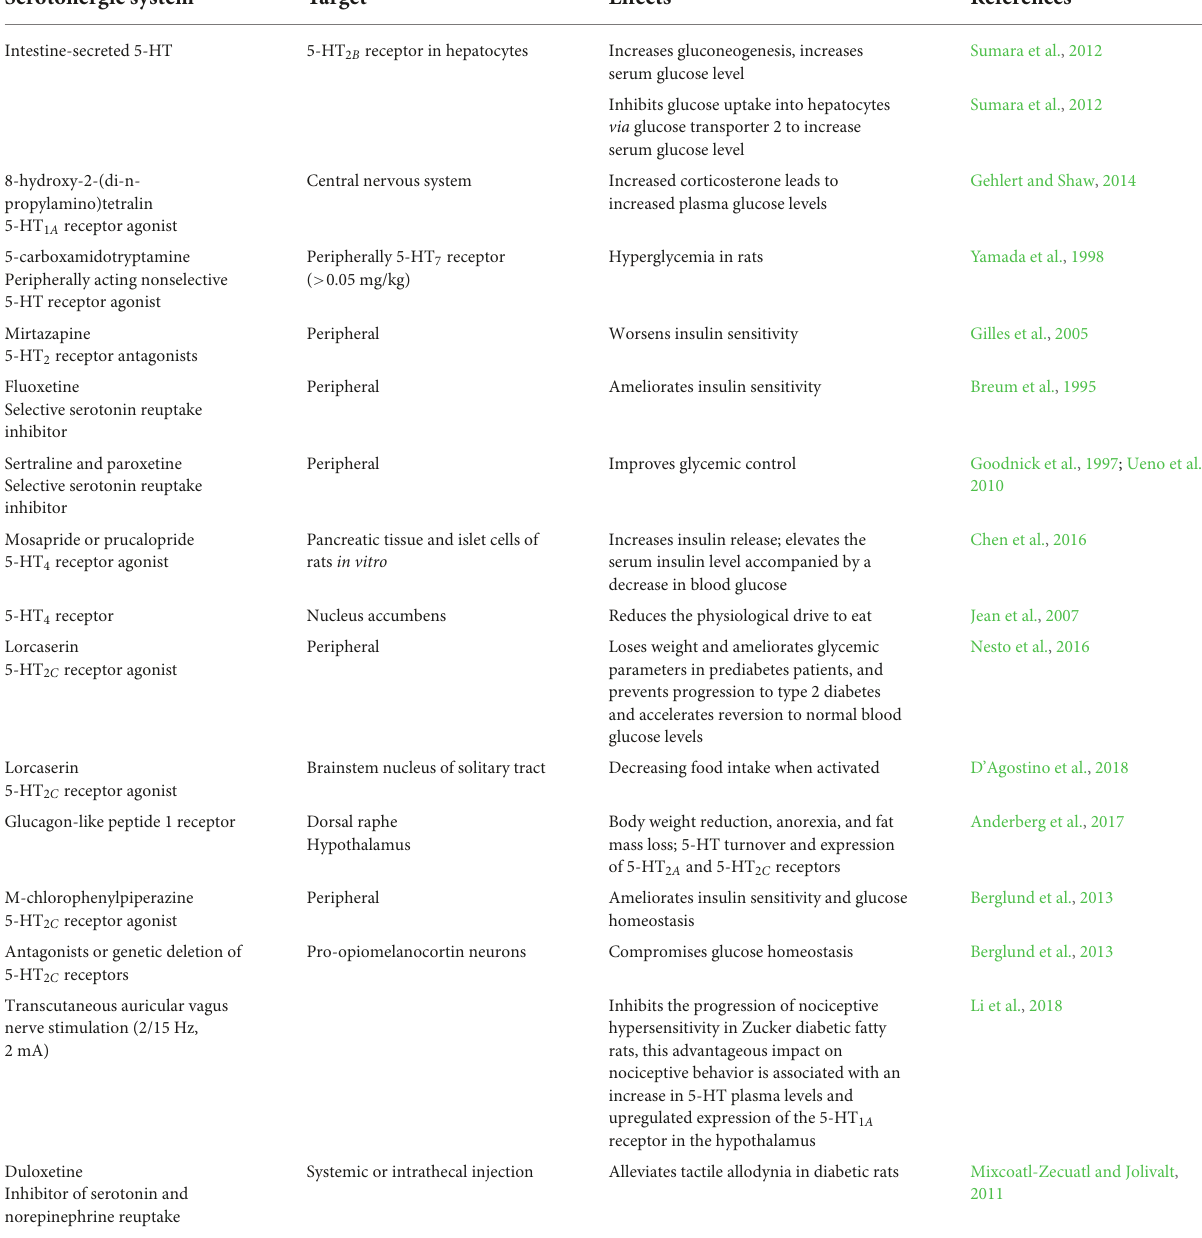
TABLE 1 Summary of the role of serotonergic system in diabetes and its